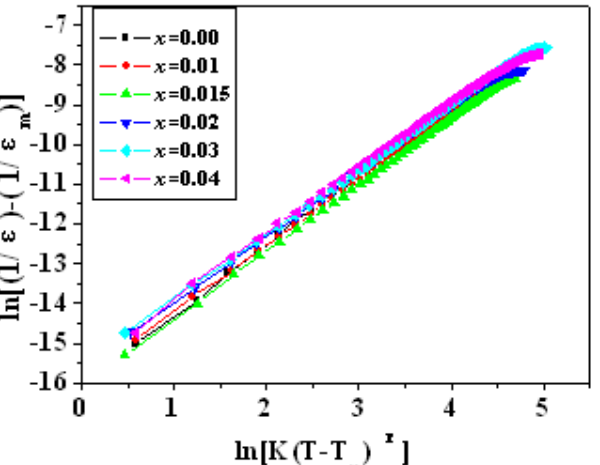
Figure 11. Variation in the reciprocal of ε with T − T m in PZTN ceramics sintered at 1260 °C for 2 h. Table 2. Diffusion coefficients ( γ ) of PZTN ceramics sintered at 1260 °C for 2 h.